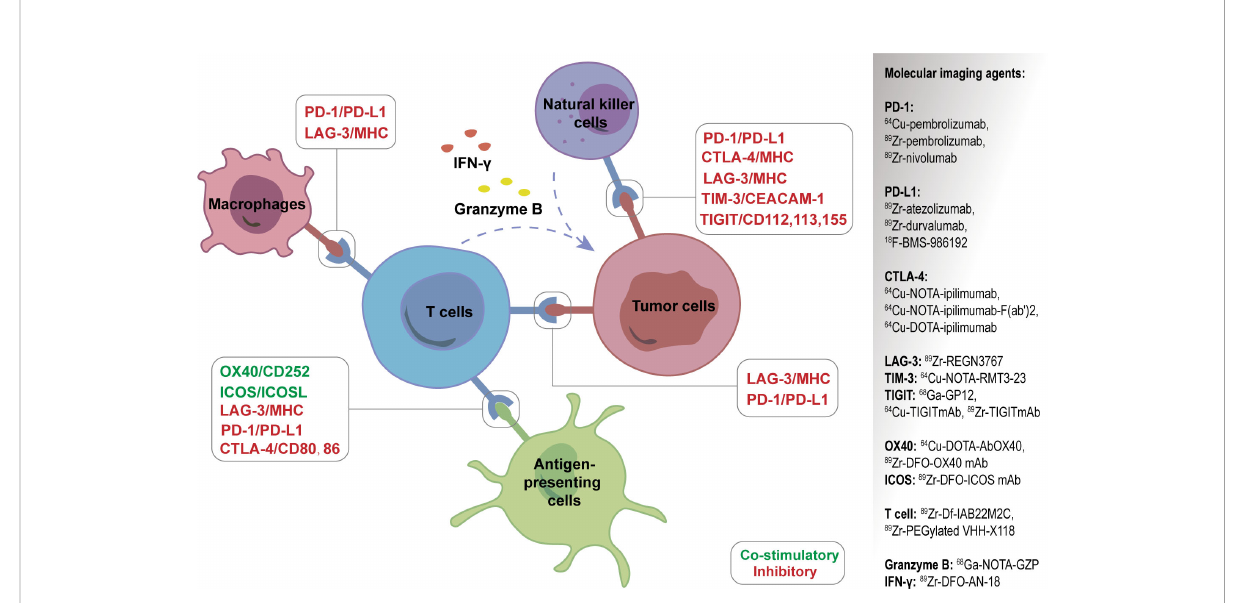
FIGURE 5 A series of new PET molecular probes targeting the compositions of tumor microenvironment